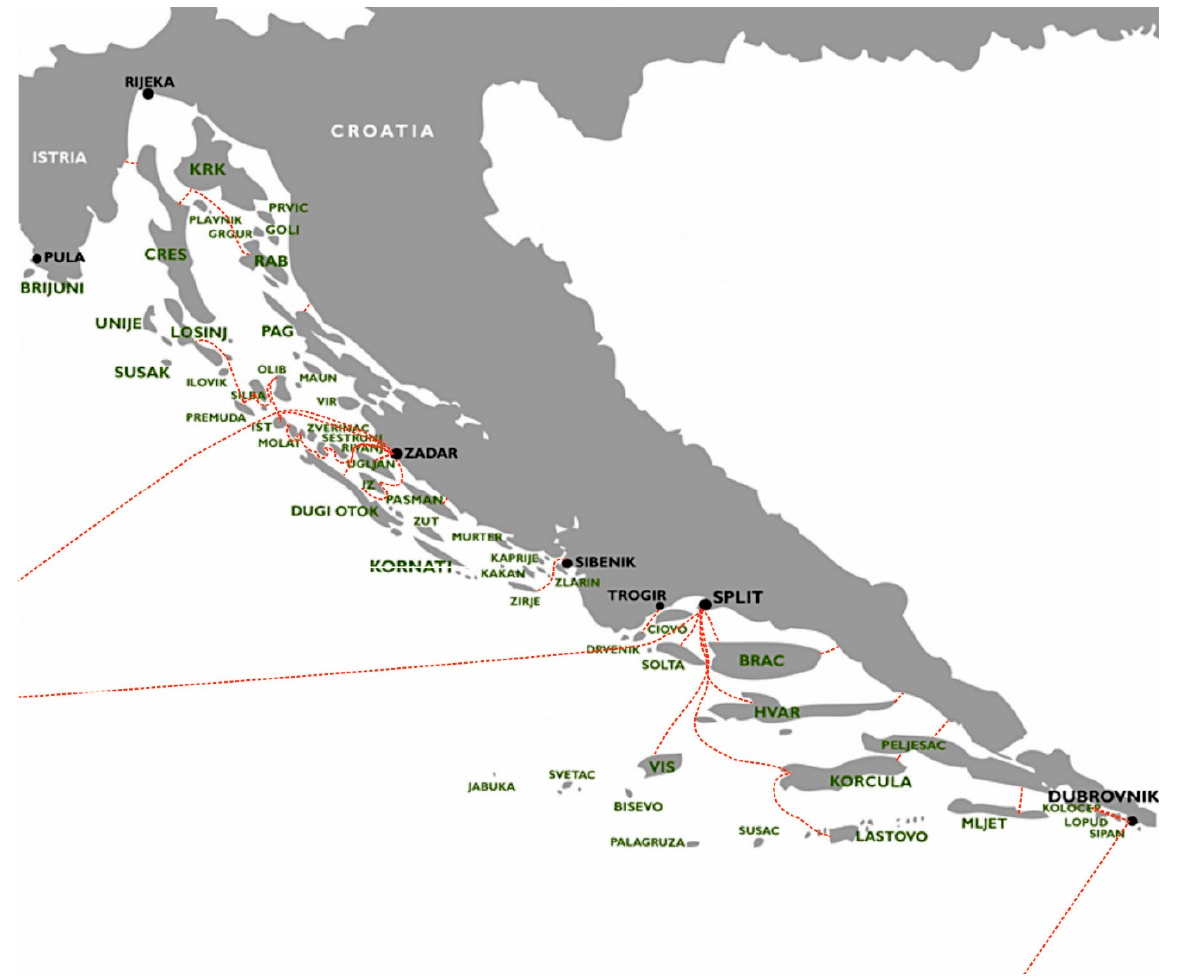
Figure 3. Croatian ferry lines. Table 1. Particulars of selected ships